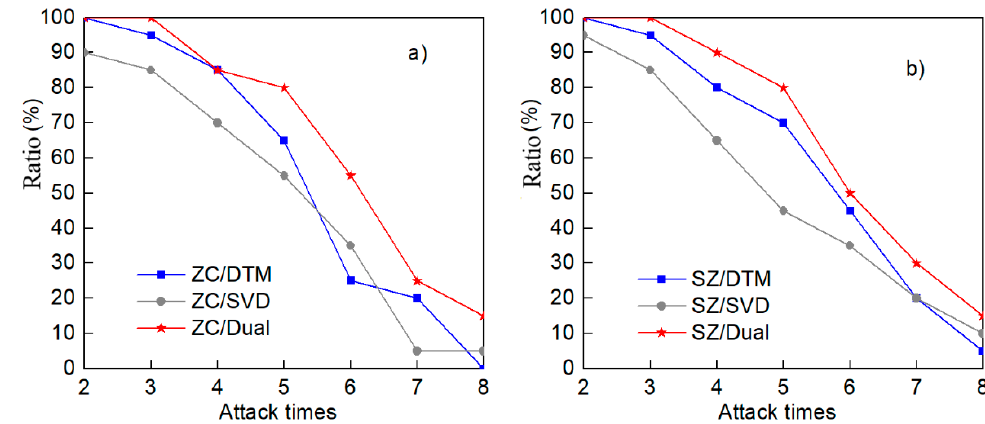
Figure 9. The ratio distribution of watermarks for NC higher than 0.8 under different numbers of compound attack in ( a ) ZC and ( b ) SZ.